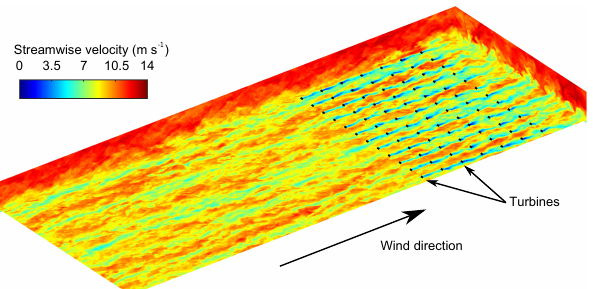
Figure 3. Instantaneous streamwise velocity contours for a large- eddy simulation with actuator disk turbine models, which are in- dicated by black dashes. Each turbine has a rotor diameter of D = 100m and hub height of 100m. The mean and maximum in- let velocities are approximately 9.5 and 12ms − 1 , respectively. The inlet conditions are generated using a concurrent precursor simula- tion (Stevens et al., 2014b) shown at the beginning of the plotted